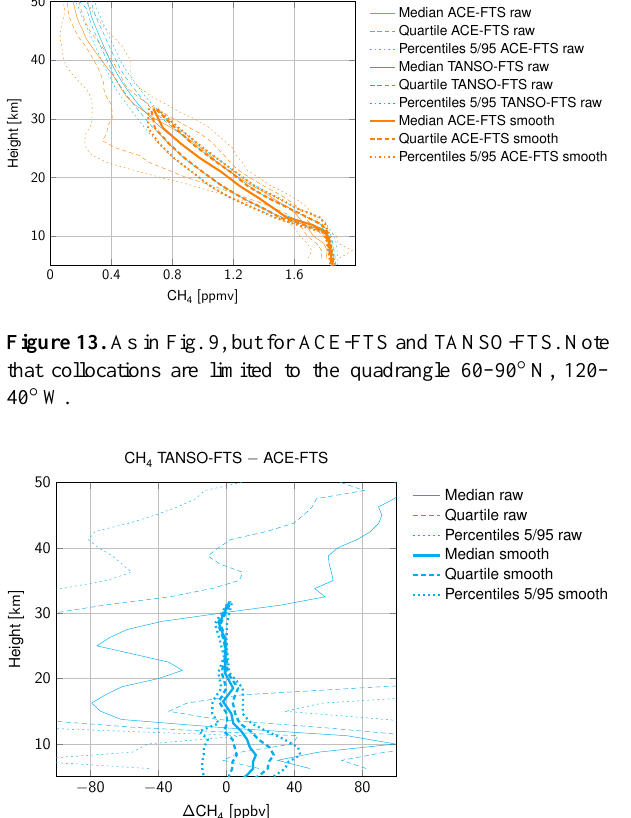
method described in Sect. 3.2. We choose to show (cid:49) CH 4 vs. PEARL-FTS CH 4 rather than ACE vs. PEARL, so that the difference and its dependences are apparent. Horizon- tal error bars show uncertainties calculated from random uncertainty in PEARL-FTS, propagated to partial columns with an equation similar to Eq. (9), but using S PEARL-FTS . Vertical error bars show σ tot = σ PC + σ pT , where the com- ponents on the right hand side are described in Eqs. (9) and (5), respectively. Systematic errors are not consid- ered in this error calculation. Note that data shown here are not filtered by sPV values, since we did not find that this improved the comparison (see above). The fig- ure shows that for most collocation pairs, there is a sig- nificant difference between the two retrievals. All differ- ences lie within a range of ± 3 × 10 22 moleculescm − 2 for a range of PEARL-FTS partial columns between 1 . 3 × 10 23 and 1 . 9 × 10 23 moleculescm − 2 . The median difference ACE- FTS–PEARL-FTS is − 2 . 6 × 10 21 moleculescm − 2 , which corresponds to 1.6 % of the median PEARL-FTS partial col- umn of 1 . 64 × 10 23 moleculescm − 2 . The median absolute de- viation (MAD) is 2 . 6 × 10 21 moleculescm − 2 . The linear